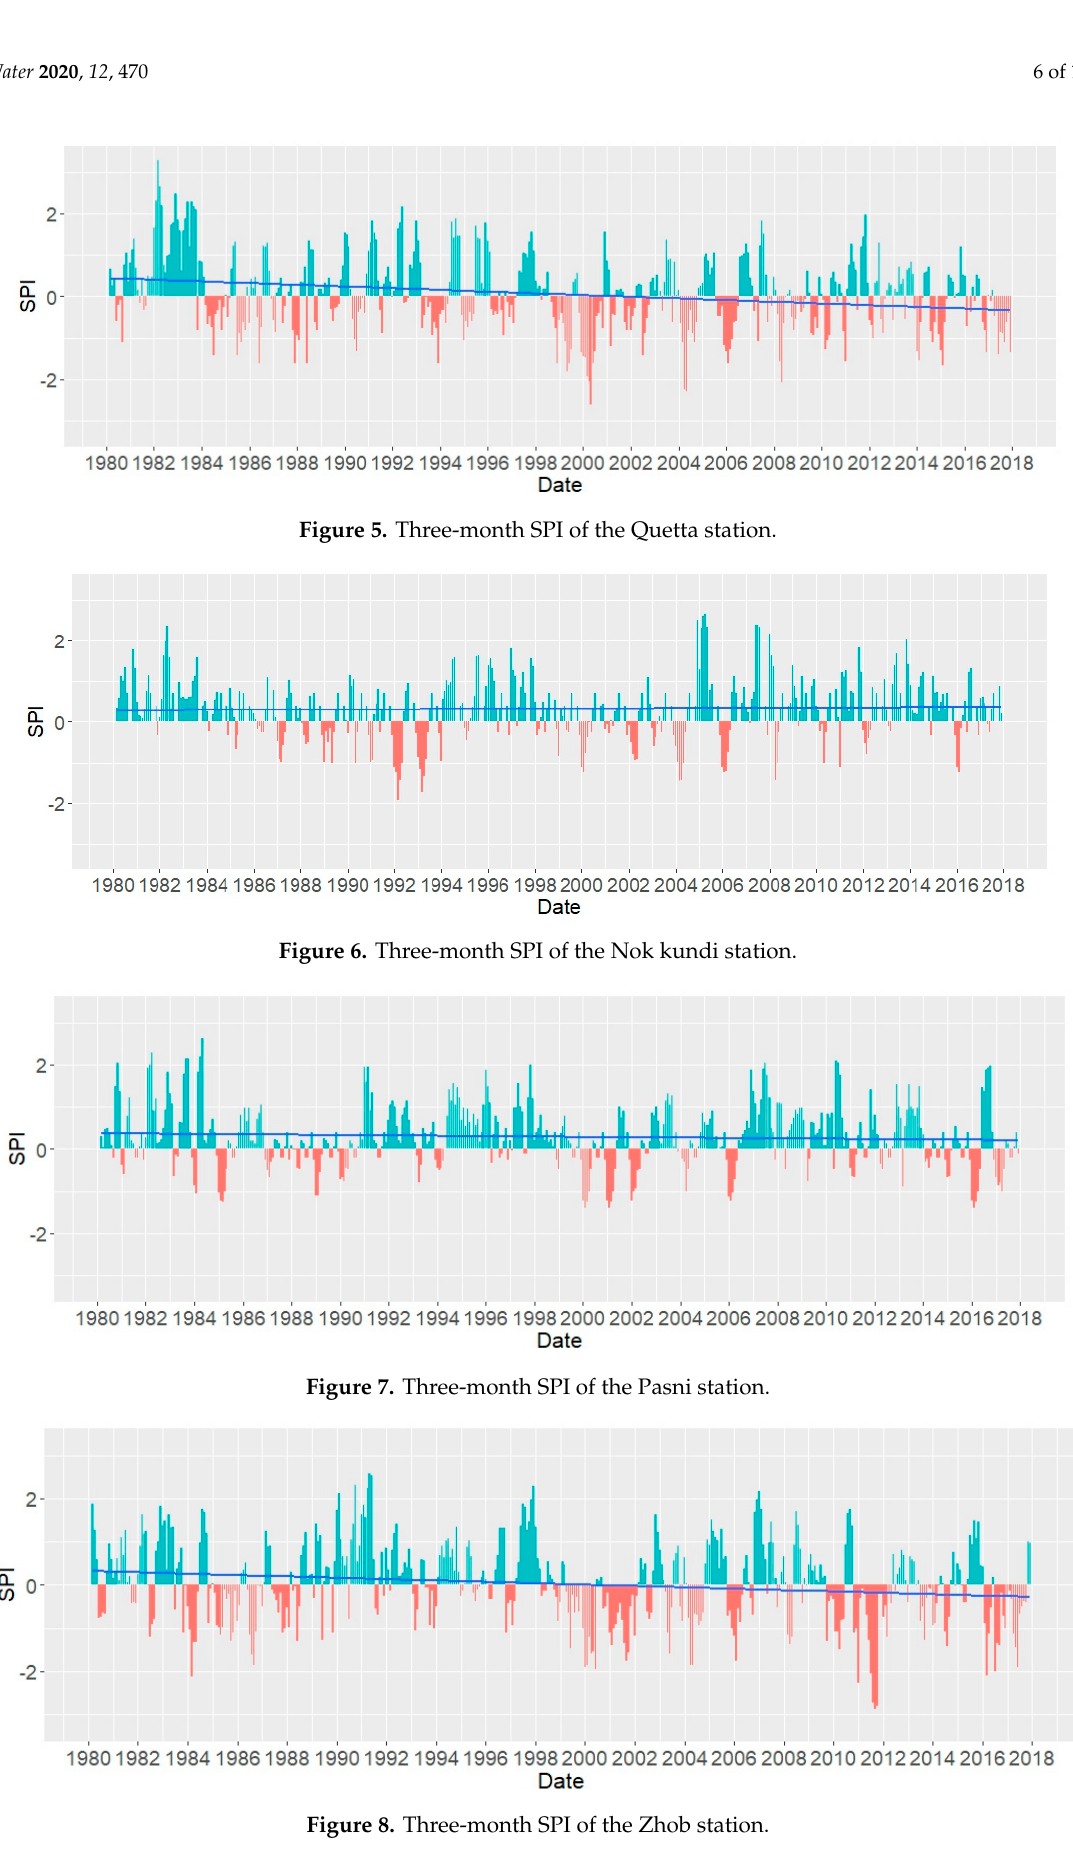
Figure 9. Three-month SPI of the Khuzdar station. Figure 10. Three-month SPI of the Panjgur station. Figure 11. Three-month SPI of the Sibbi station.